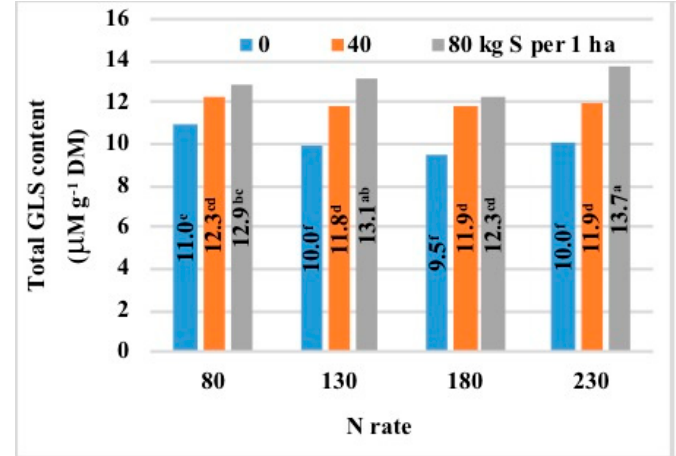
Figure 14. The relationship between N and S rates vs. the total GLS content of winter oilseed rape seeds, across years. Means with the same letters do not di ff er significantly at p ≤ 0.05 in Tukey‘s